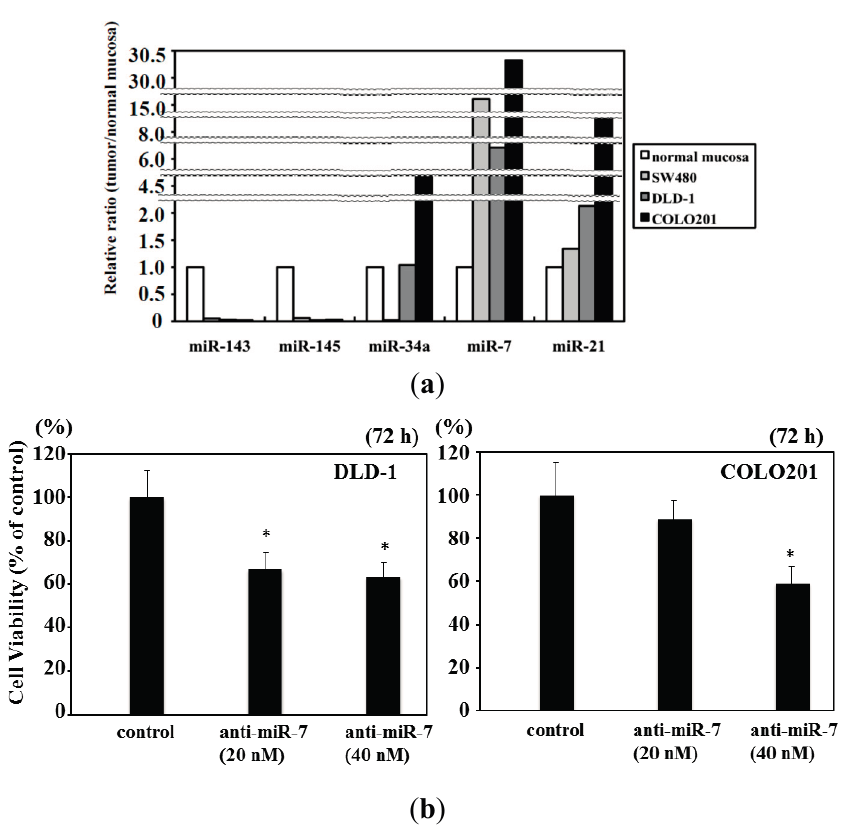
Figure 4. Expression of miR-143, -145, -7, -34a, and -21 in human colon cancer cell lines. ( a ) Expression of the indicated miRNAs in various human colon cancer cell lines. The relative expression level in the cells transfected with control miRNA is indicated as “1”; and ( b ) Effect of ectopic expression of anti-miR-7 on proliferation of human colon DLD-1 and COLO201 cells. Anti-miR-7 was used for the transfection of the cells (20–40 nM), which was achieved by using cationic liposomes. The effects manifested by the introduction of the anti-miR-7 were assayed at 72 h after the transfection. The viable cell number of control cells at 72 h after the transfection is indicated as “100%”. Wave line: omission of vertical axis. *: There is statistical significant compare with normal